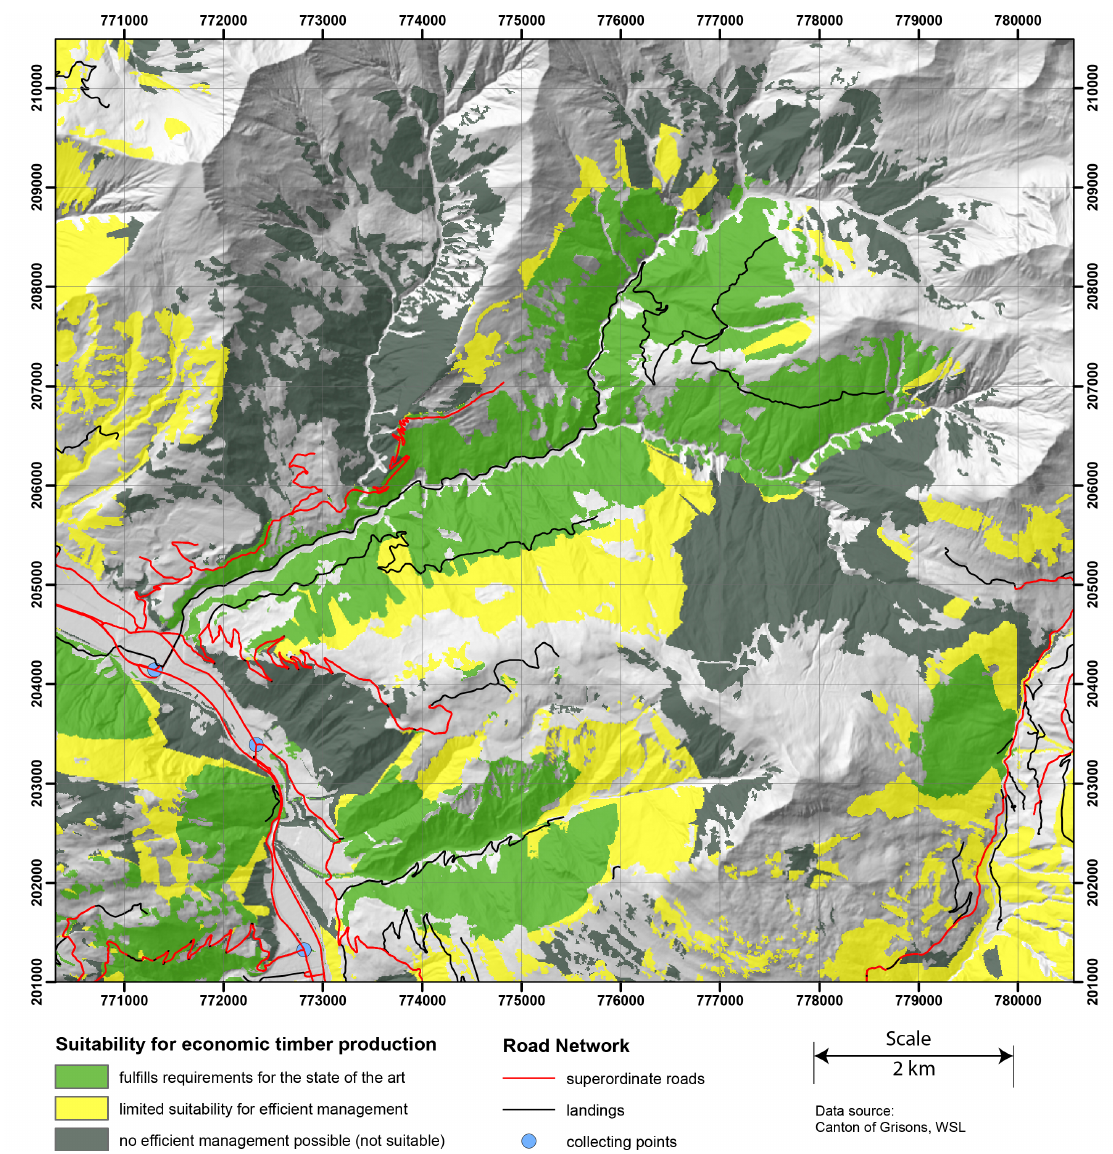
Figure 9. Extract from suitability map for region near Schiers in the canton of Grisons, Switzerland (hillshade dtm © swisstopo